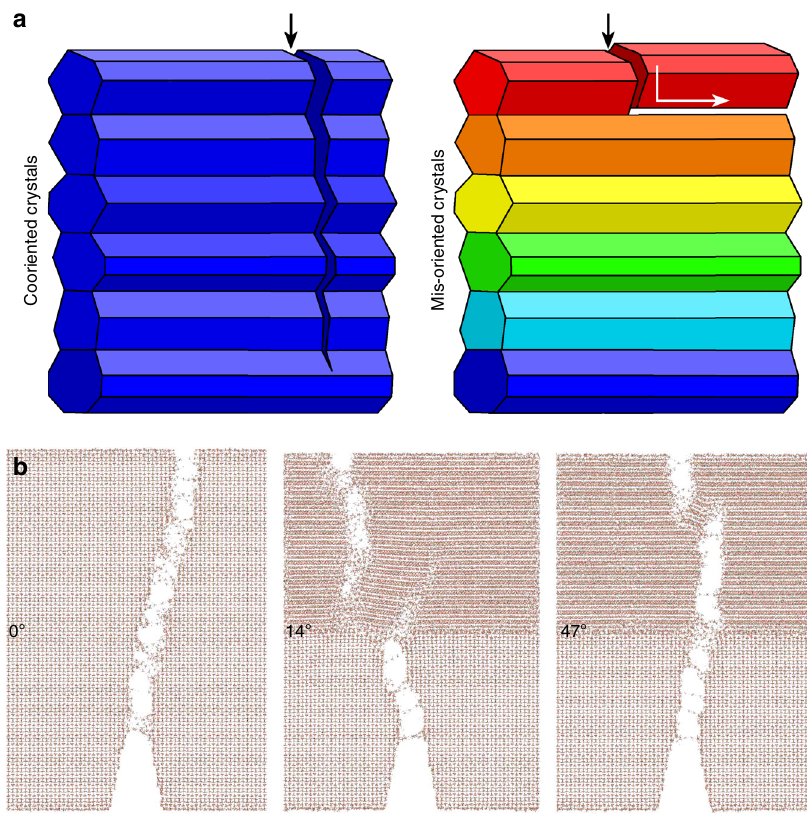
Fig. 5 Crystal mis-orientation provides a toughening mechanism. a Schematic of the mechanisms: co-oriented crystals (blue) enable crack propagation across different crystals, precisely because they are co-oriented. When crystals are mis-oriented (colors), instead, cracks de fl ect at crystal interfaces, thus they cannot propagate or grow over long distances, and the material is tougher. b Molecular dynamics simulations of grain boundaries, where hydroxyapatite crystals are mis-oriented by 0°, 14°, or 47°. Notice that the crack starting from the bottom propagates straight through the 0° interface, is de fl ected at the 14°, and again not de fl ected at the 47° interface. See Supplementary Movies 1, 2, 3